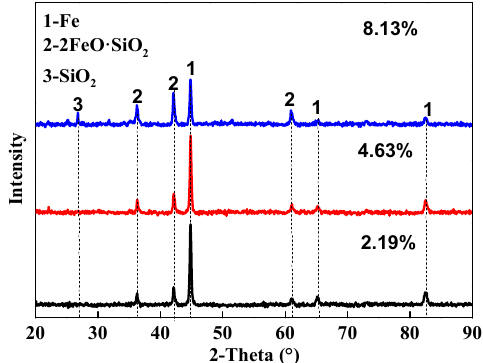
Figure 8. XRD analysis of reduction pellets with different SiO 2 content.